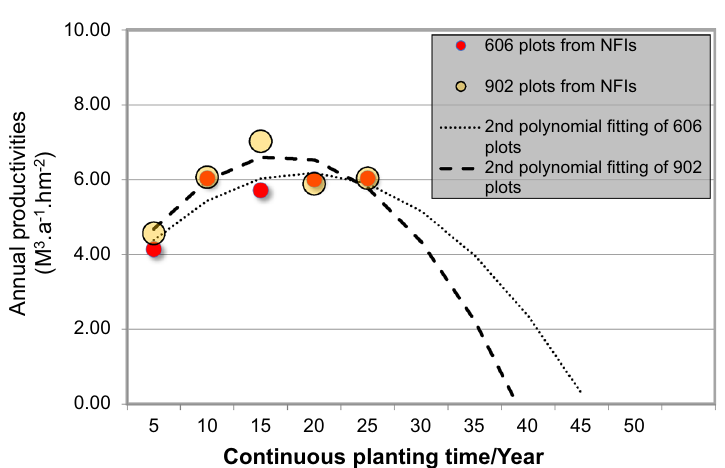
Figure 5. Statistical model showing how mean annual productivity of eucalyptus sample plots changes with